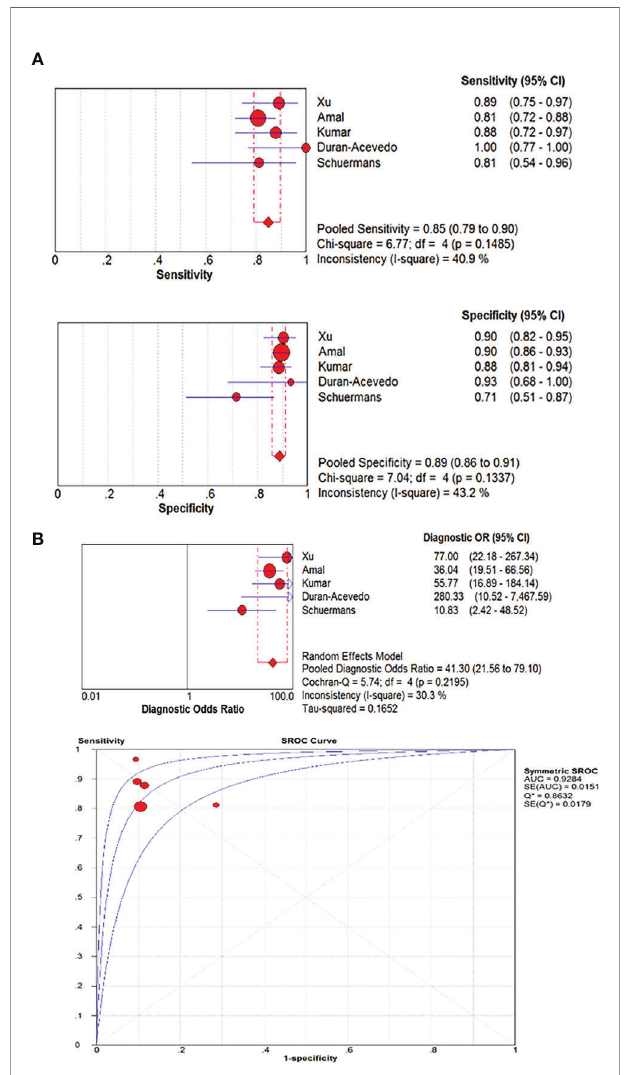
FIGURE 4 | The pooled sensitivity, speci fi city, diagnostic odds ratio and SROC curve of exhaled VOC pro fi les in GC diagnosis. (OR, odds ratio; CI, con fi dence interval; DOR, diagnostic odds ratio.) (A) The pooled results reported a mean sensitivity of 85% (79% to 90% CI) and speci fi city of 89% (86% to 91% CI). (B) The mean (95% CI) pooled DOR was 41.30(21.56 – 79.10). The area under the SROC curve(AUC) was 0.93.